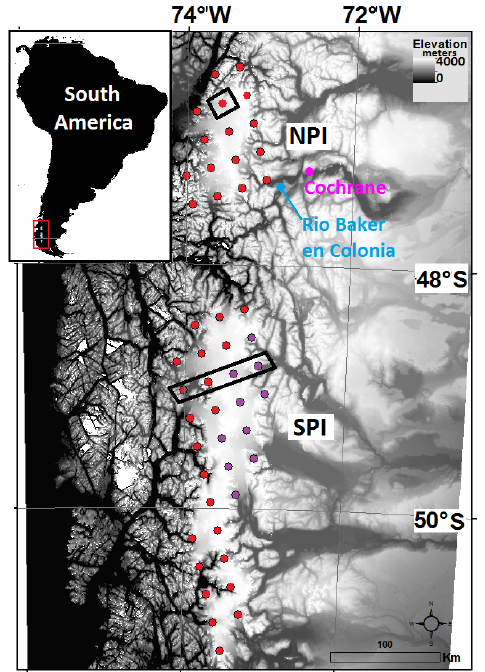
Figure 4. Digital elevation map (SRTM, 90 m resolution) for the Northern (NPI) and Southern (SPI) Patagonian Icefields. Dots are the center of the 25 km EASE-grid pixels and colors indicate general melt regime pattern from Figure